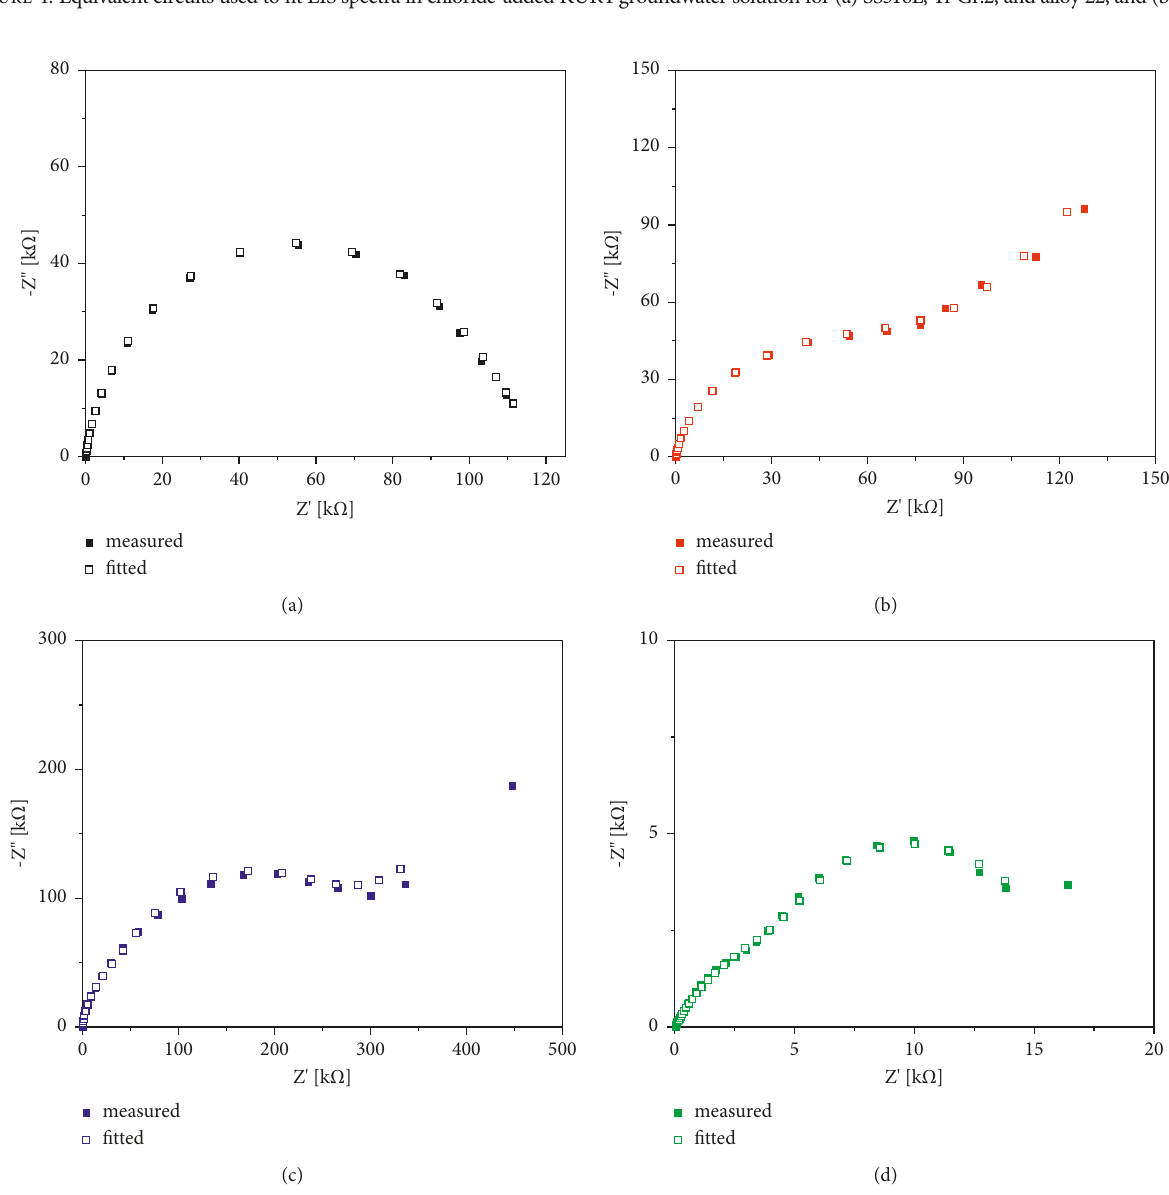
Figure 5: Measured and fitted data of impedance of (a) SS316L, (b) Ti-Gr.2, (c) Alloy 22, and (d) Cu in chloride-added KURTgroundwater solution at 25 °